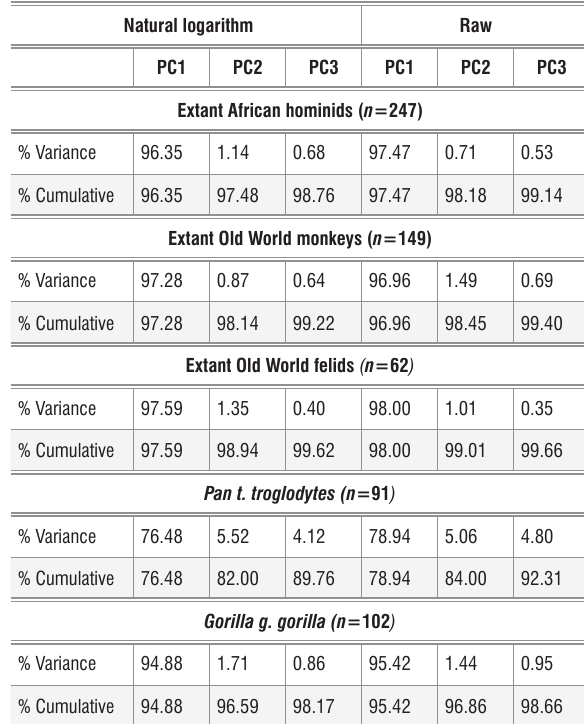
Summary statistics for the principal components (PC)